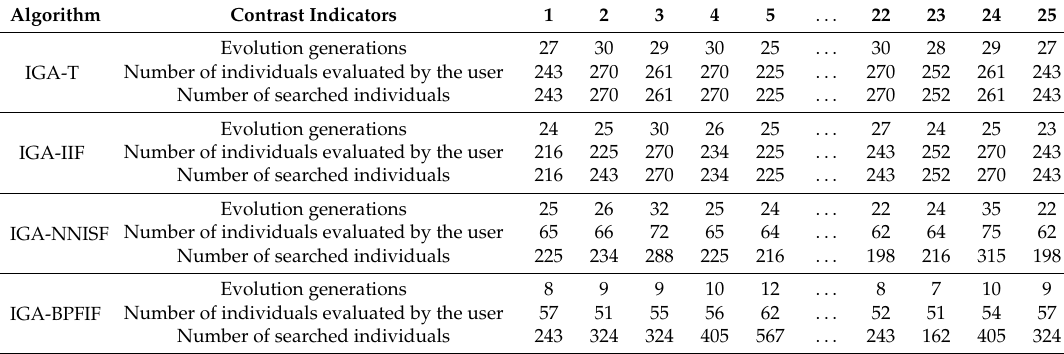
Table 3. Contrast indicators comparison.